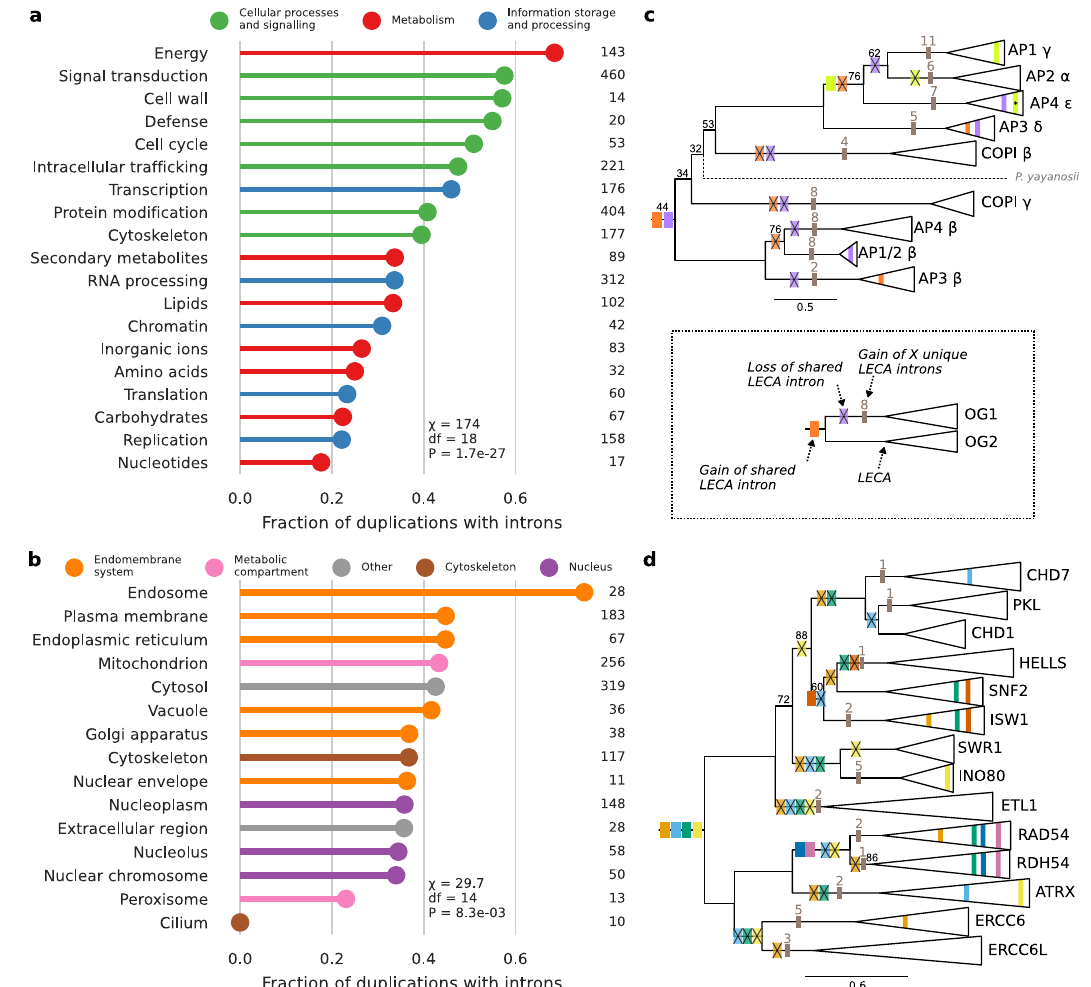
Fig. 3 Reconstruction of pre-duplication introns in Pfam duplications of different functions and cellular localisations. a , b Fraction of duplications with introns traced to their pre-duplication state according to functional category ( a ) and cellular localisation ( b ). Thirty percent of pairwise comparisons of functions were signi fi cant (Supplementary Data 4). 14% of pairwise comparisons of localisations were signi fi cant, which were only comparisons including the endosome and cilium (Supplementary Data 5). Numbers indicate the number of duplications. Only functions and localisations with at least ten duplications are shown. c , d Excerpts from the gene trees of the adaptin (PF01602) ( c ) and SNF2 family (PF00176) ( d ) with the reconstructed presence of introns depicted. The triangles and names correspond to the Pfam OGs. The shared LECA introns in a Pfam OG are coloured and the gain and loss of these introns is mapped onto the phylogeny. The number of unique LECA introns is indicated in grey. Ultrafast bootstrap support values lower than 100 are shown. The branch with a prokaryotic sequence that fell between the Pfam OGs in ( c ) is shown as a dotted line. The shared intron in AP4 ε that is marked with an asterisk was classi fi ed as a U12-type intron. Although the phylogenetic position of the two COPI subunits is probably incorrect, the inferred intron gains and losses in these trees are largely unaffected by topology